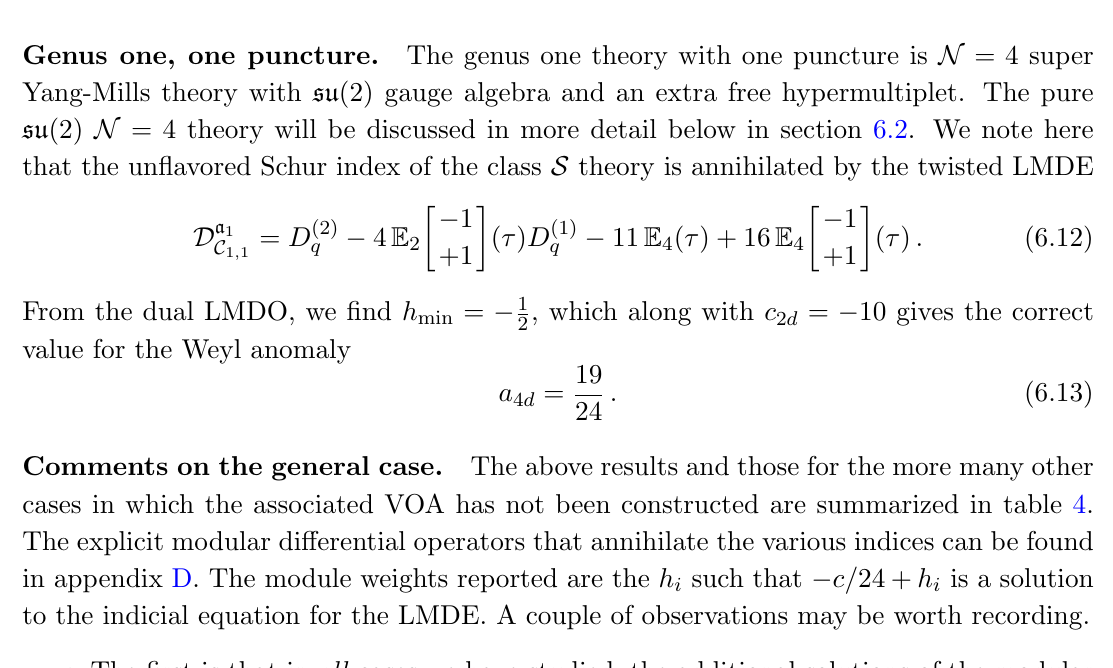
Table 4 . Summary of modular differential operators that annihilate the vacuum characters of class vertex operator algebras of type a 1 . Provided are the order of the minimal modular differential S operator that annihilates the vacuum character, the modular subgroup under which the correspond- ing differential equation is invariant, the list of solutions of the indicial equation, and the dimension of V D , the vector space of modular differential operators at the given order that mutually annihilate the vacuum